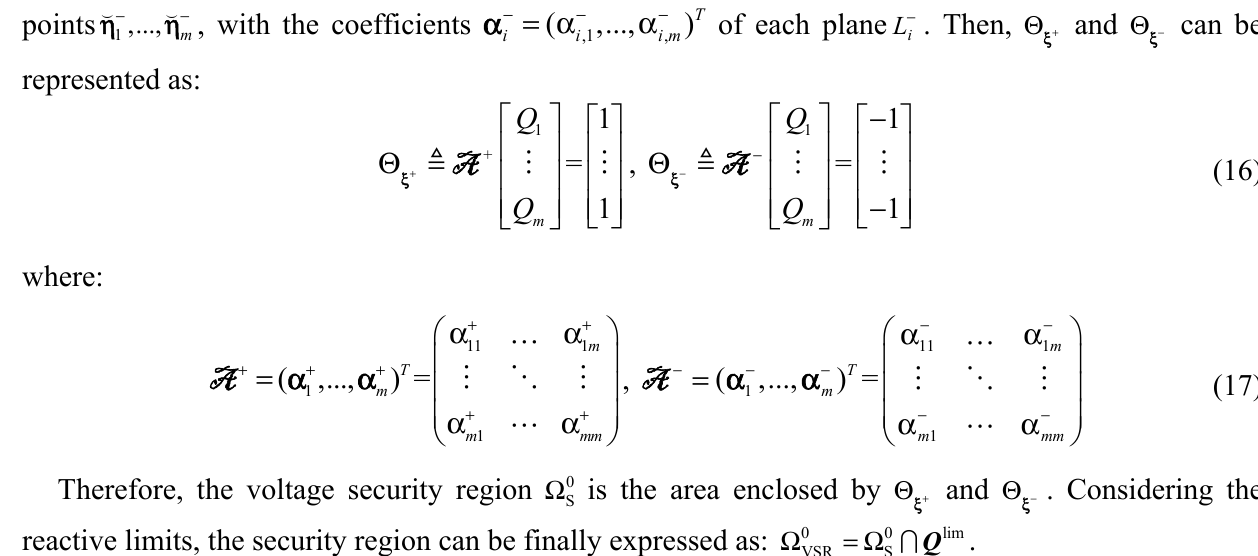
: ( a ) Using two near points ξ S